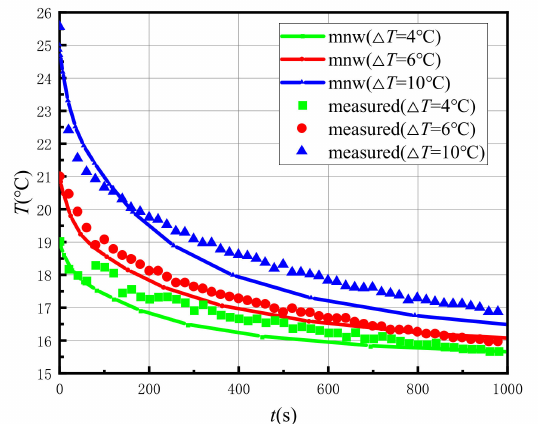
Figure 12. Comparison of the temperature variation of the test section in the test well under different excitation strengths between the numerical simulation and the measured value in the case of u = 0.